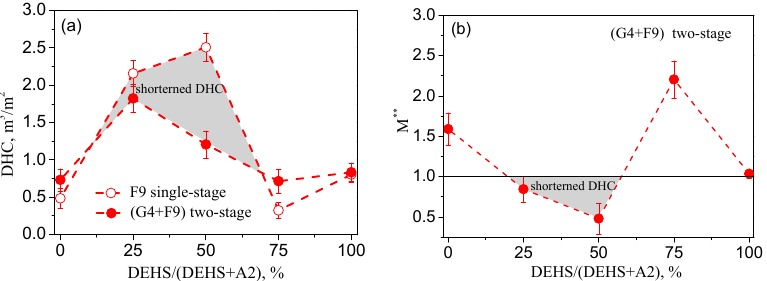
Figure 11. The ( a ) DHC and ( b) M** of a (G4 + F9) two-stage case when loaded with different oil-coated